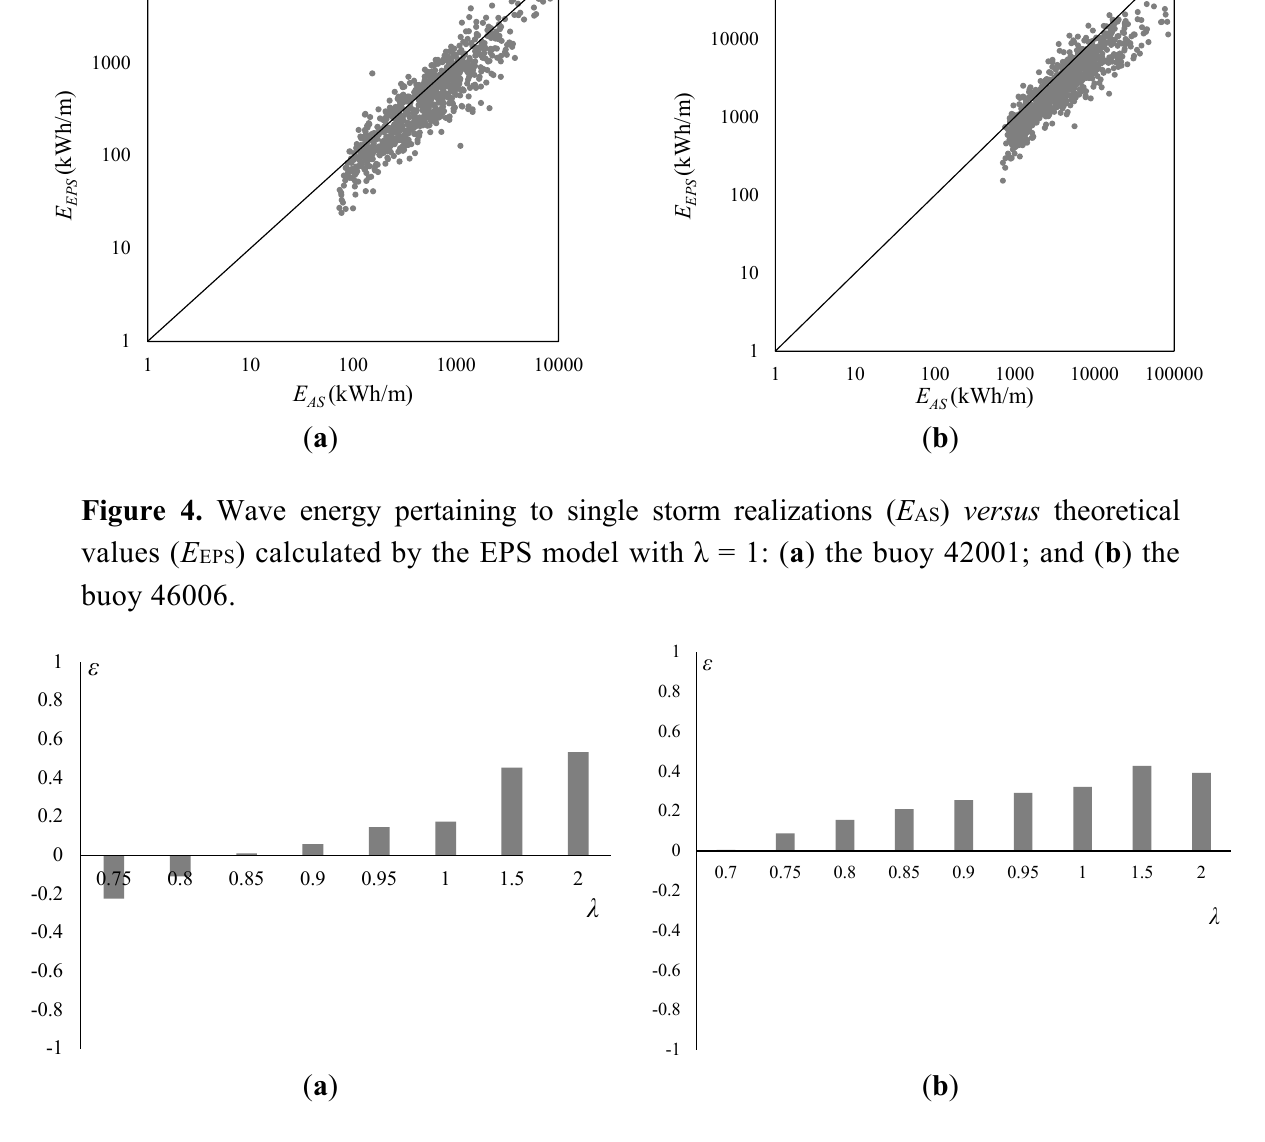
Figure 5. Error in Equation (23) calculated for various storm shapes from data ( a ) of the buoy 42001 and ( b ) of the buoy